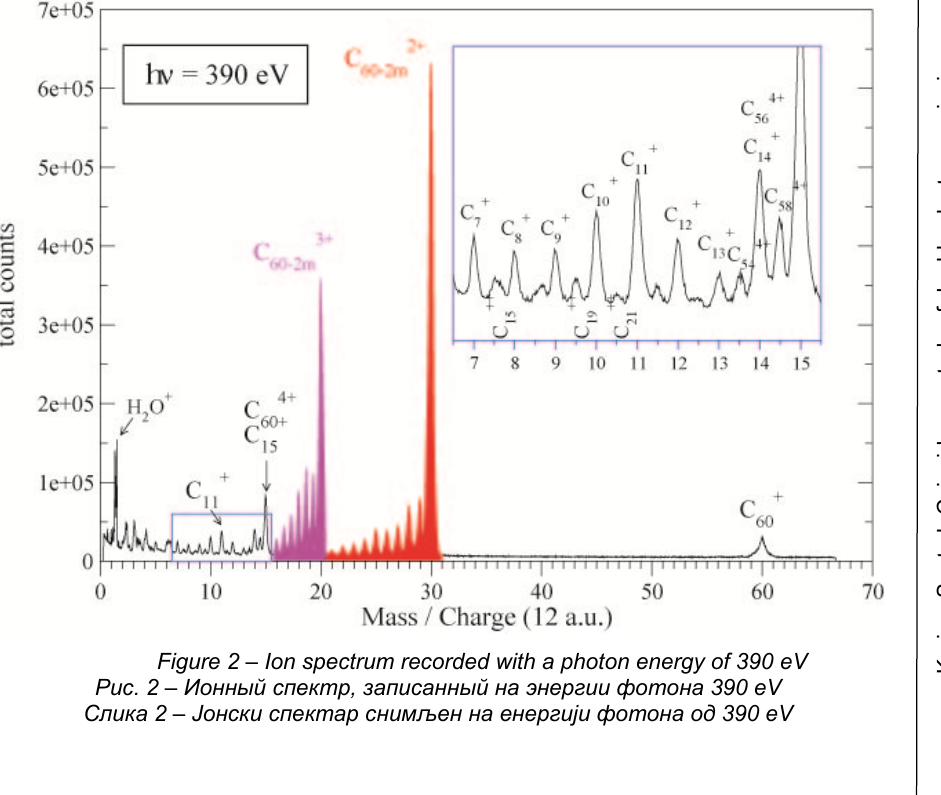
Figure 2 – Ion spectrum recorded with a photon energy of 390